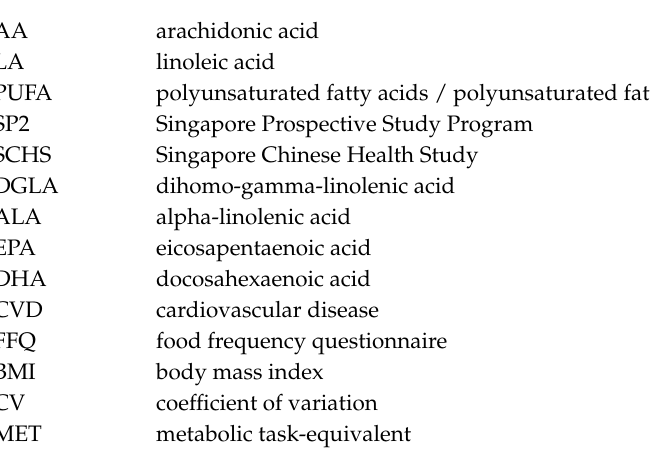
Table S1: Characteristics and plasma fatty acid composition (weight %) of the Singapore Chinese Health Study participants ( n = 769), Table S2: Association between consumption of meat and meat alternatives, polyunsaturated fat (PUFA) and plasma fatty acid composition (weight %) of the Singapore Chinese Health Study participants ( n = 769) stratified by sex ( n = 497 for men, n = 272 for women), Table S3: Association between consumption of meat and meat alternatives, polyunsaturated fat (PUFA) and plasma fatty acid composition (weight %) of the Singapore Chinese Health Study participants ( n = 769) stratified by age ( n = 367 for age < 60 years, n = 402 for age ≥ 60 years), Table S4: Association between consumption of meat and meat alternatives, polyunsaturated fat (PUFA) and plasma fatty acid composition (weight %) of the Singapore Chinese Health Study participants ( n = 769) stratified by overweight status ( n = 394 for BMI < 23 kg/m 2 , n = 375 for BMI ≥ 23 kg/m 2